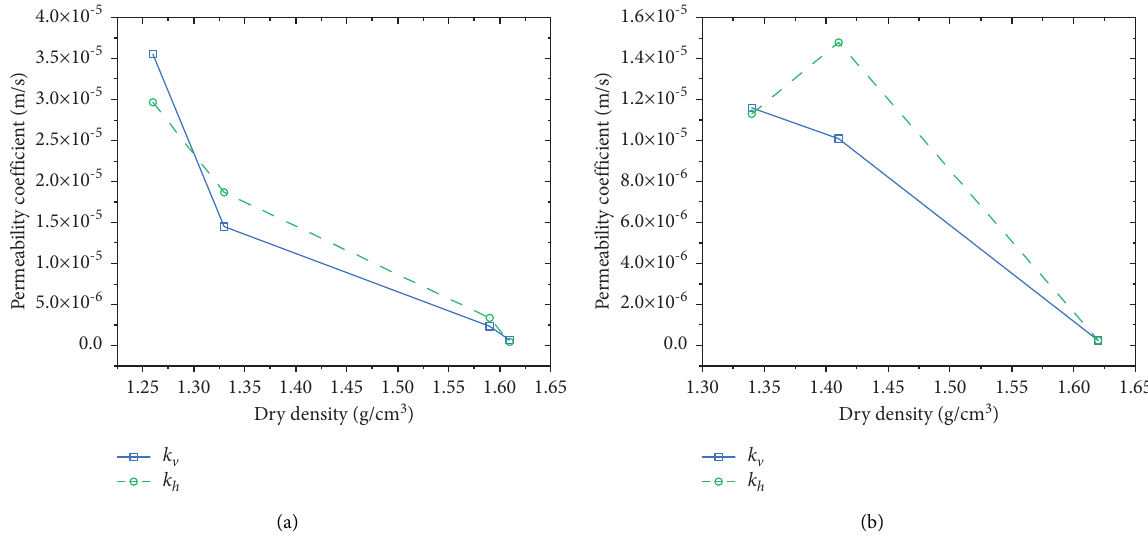
Figure 10: Relationship between permeability coefficient and dry density of the intact loess. (a) ω � 10%. (b) ω �